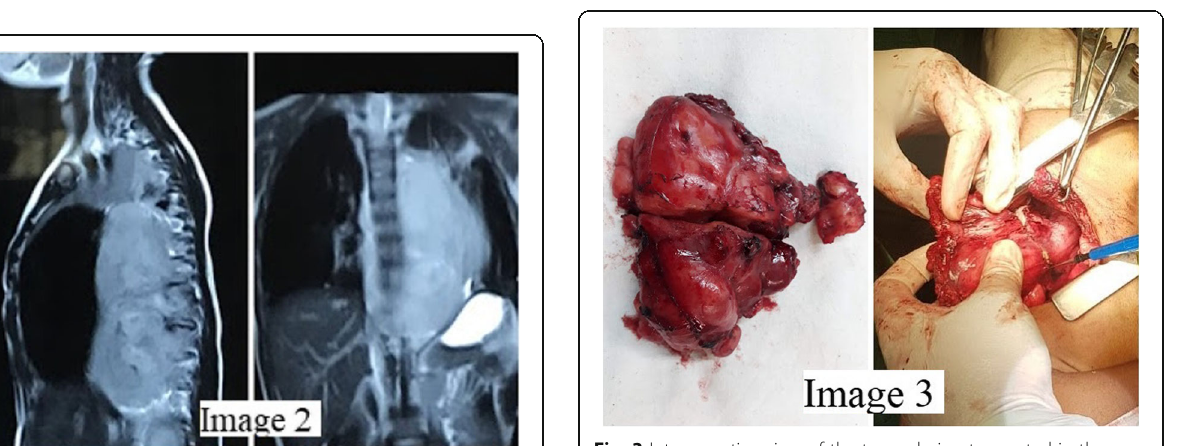
Fig. 3 Intraoperative view of the tumor being transected in the middle and the resected mass showing the attached infiltrated lymph